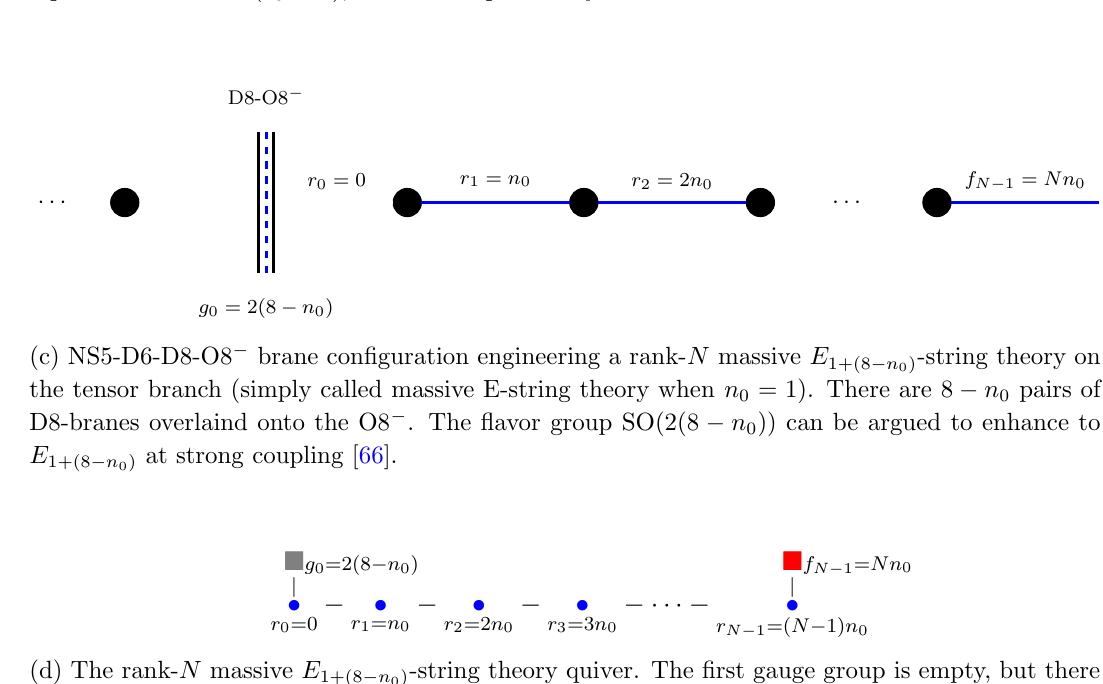
Figure 4. Quivers engineered by NS5-D6-D8-O8 (cid:6) brane con(cid:12)gurations. Notice that we